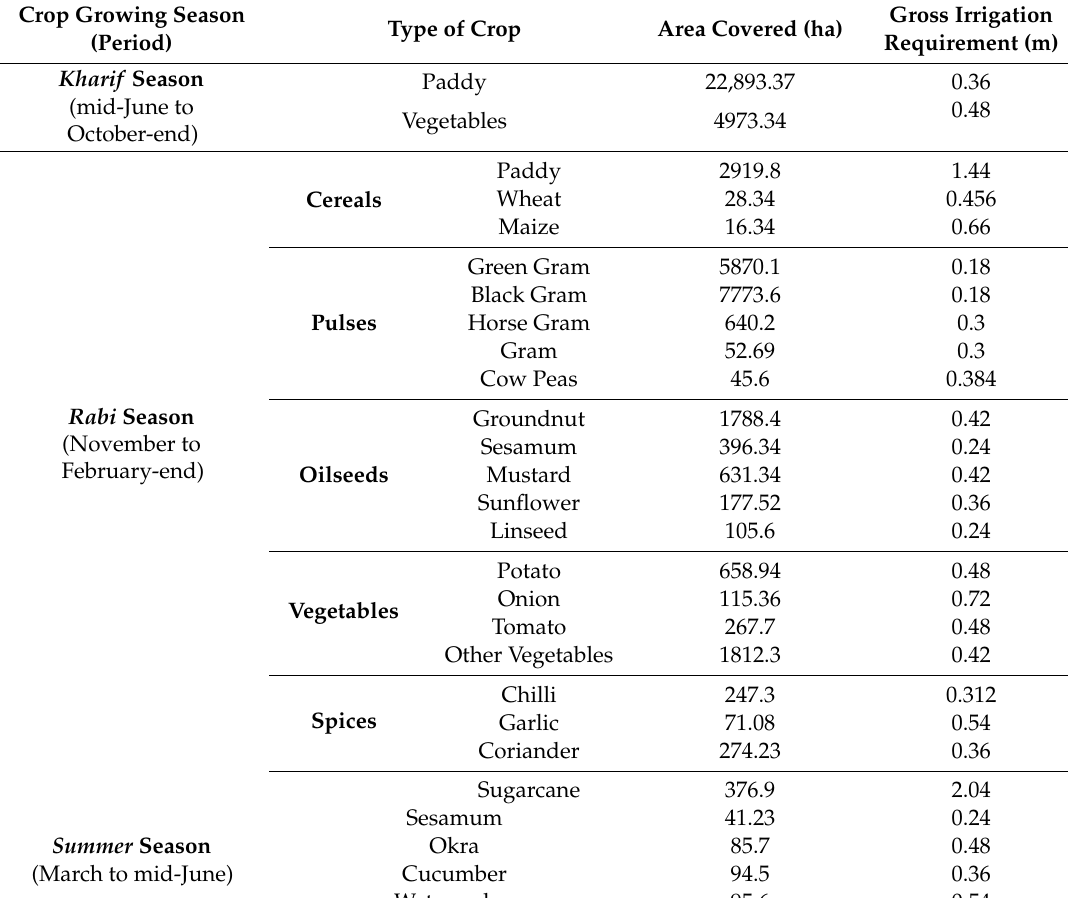
Table 1. Area covered and Gross Irrigation Requirement for the crops grown in Kharif , Rabi , and Summer cropping